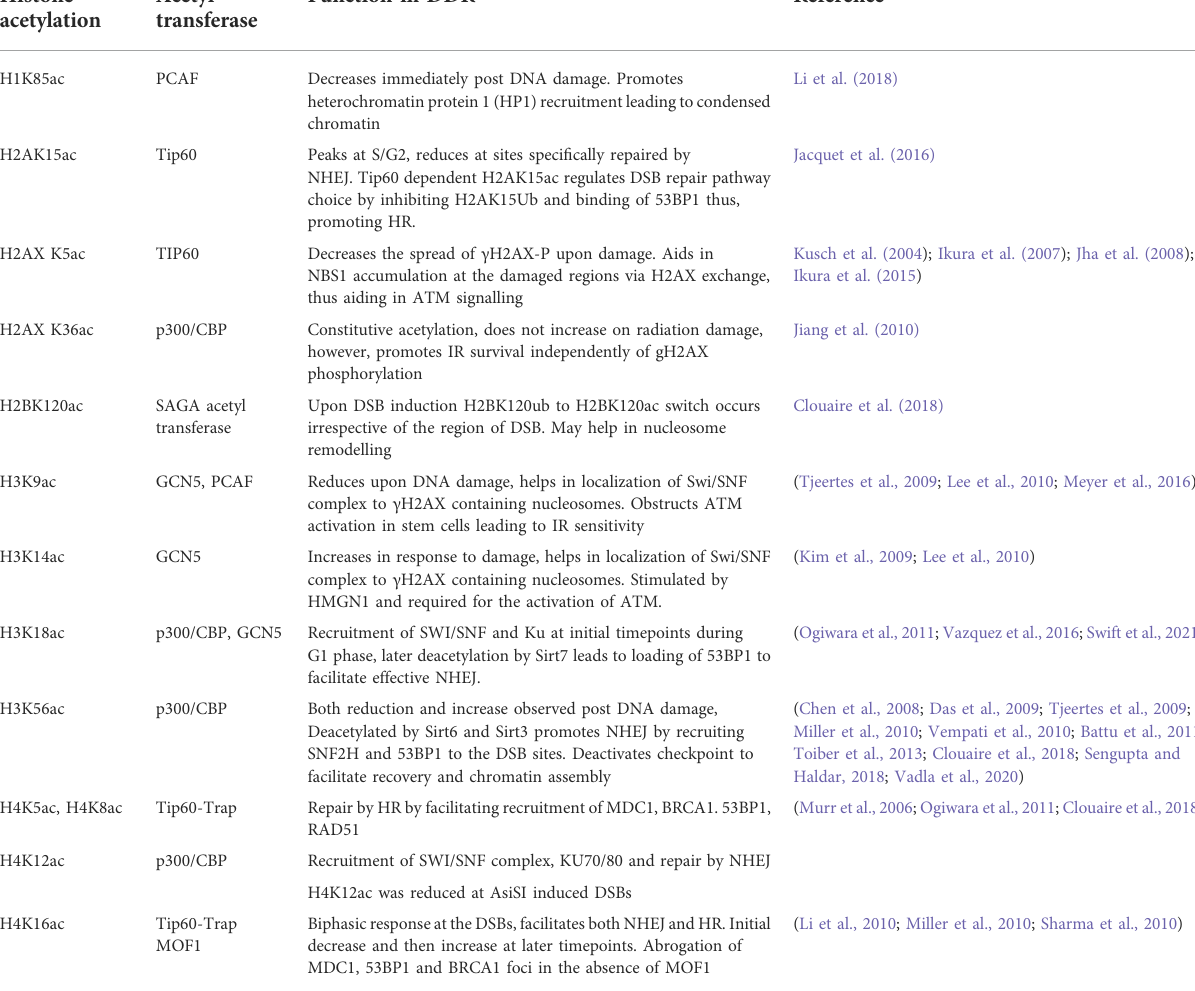
TABLE 1 List of acetyl lysine modi fi cations of Histones with roles in DSB signaling and Repair. Histone